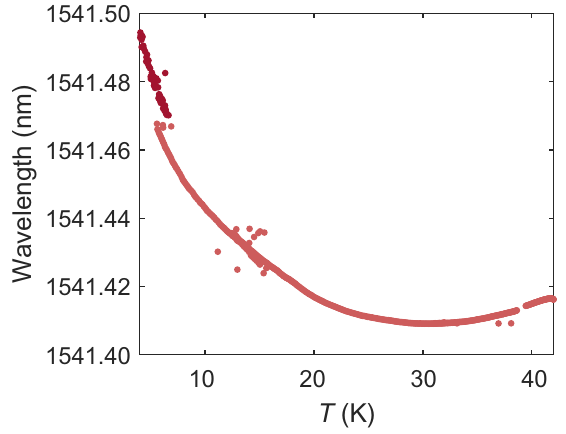
FIG. 6. Optical cavity resonant wavelength versus cryostat temperature of a silicon OMC. The measurement is performed with the OMC with κ/ 2 π = 1.6 GHz at pressure approxi- mately 100 mbar with ¯ n c < 5 by monitoring the coherent cavity response. The slight color difference at temperature below 8 K corresponds to two different sets of